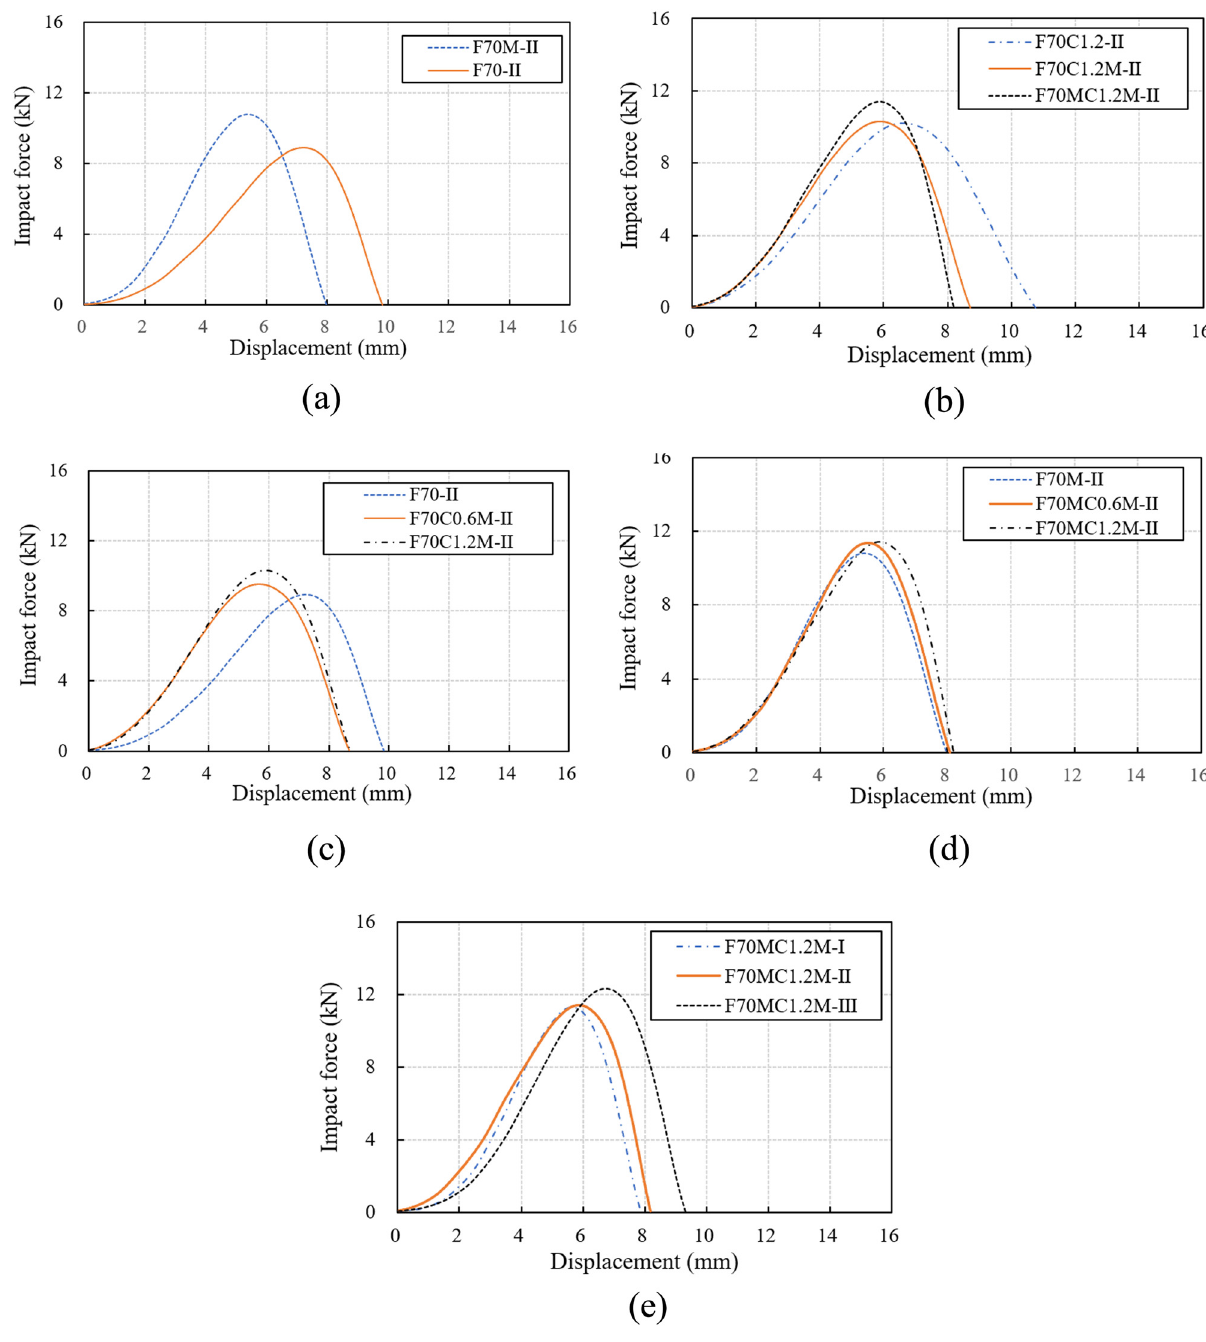
Figure 9: Impact force – displacement curves: ( a ) in fl uence of the modi fi ed HGMs, ( b ) in fl uence of the modi fi ed HGMs and MWCNTs, ( c ) in fl uence of the contents of modi fi ed MWCNTs on specimens with unmodi fi ed HGMs, ( d ) in fl uence of the contents of modi fi ed MWCNTs on specimens with modi fi ed HGMs, and ( e ) in fl uence of the applied impact